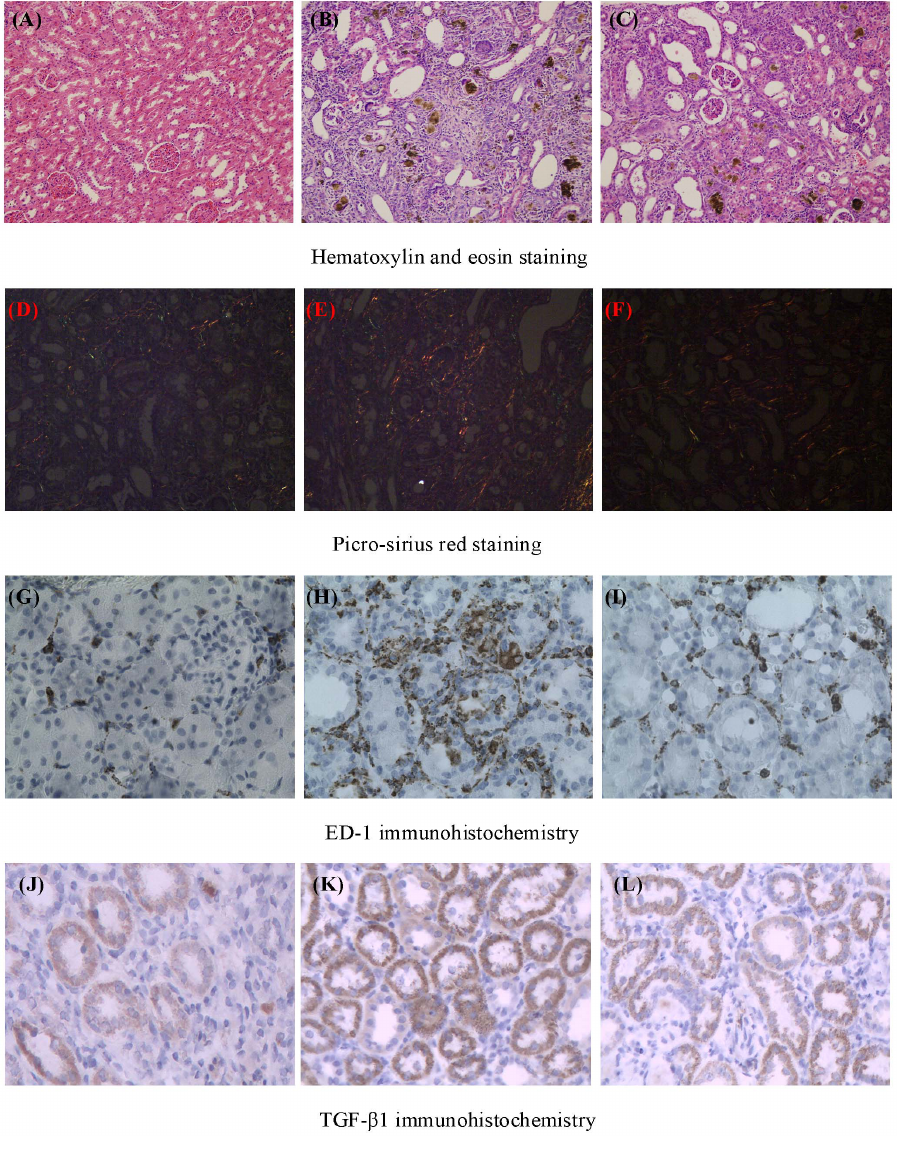
Fig. 1. Histological findings of hematoxylin-eosin and picro-sirius red staining as well as ED-1 and TGF- b 1 immunohistochemisrty. Histological findings of kidney hematoxylin-eosin staining from control (A), CKD (B) and CKD + Ergone groups (C) and picro-sirius red staining from control (D), CKD (E) and CKD + Ergone groups (F). Immunohistochemical findings by ED-1 antibody from the control (G), CKD (H) and CKD + Ergone group (I) and TGF- b 1 antibody from the control (J), CKD (K) and CKD + Ergone group (L).